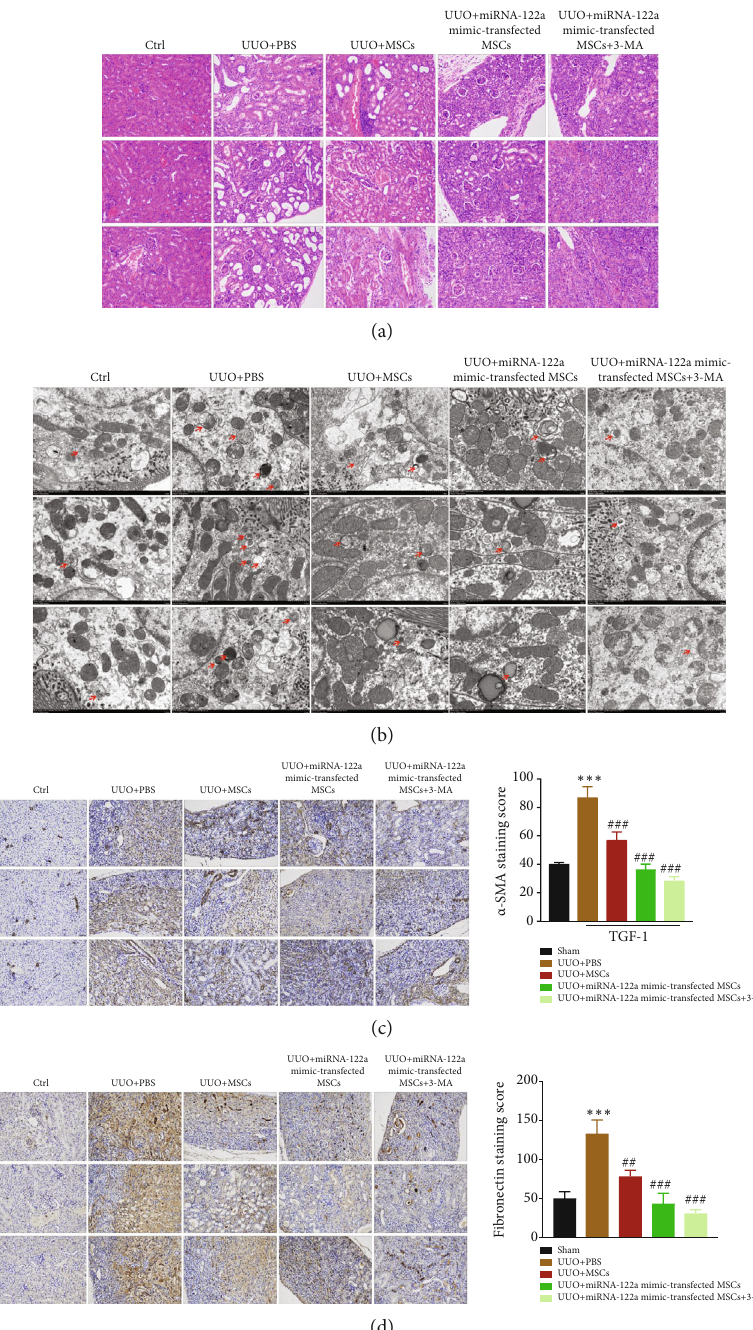
Figure 5: miRNA-122a mimic-transfected MSC treatment improves injured kidney architecture and reduces renal fi brosis in unilateral ureteral obstruction- (UUO-) injured mice. (a) Representative hematoxylin and eosin-stained sections of the sham group and UUO kidneys at 7 days postinjury treated with either PBS vehicle, miRNA-122a mimic-transfected MSCs, or miRNA-122a mimic-transfected MSCs+3-MA. (b) Autophagosomes were detected by TEM for each group of mice 24h after within the border zone. Arrowhead, autophagosomes. (c, d) Representative photomicrographs of immunohistochemical staining of α -SMA (c) and fi bronectin (d) in sham and UUO kidneys at 7 days postinjury treated with either PBS vehicle, miRNA-122a mimic-transfected MSCs, or miRNA-122a mimic-transfected MSCs+3-MA (magni fi cation ×